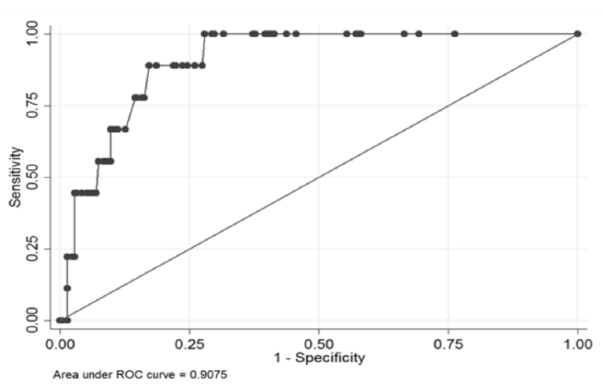
Figure 2. Area under the receiver operating characteristic (ROC) curve (AUC) of 90.7%.